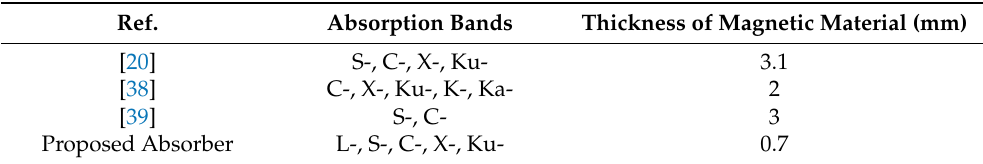
Table 2. A comparison of the absorption bands and thickness of the magnetic material of the proposed absorber with reported magnetic absorbers. Ref.